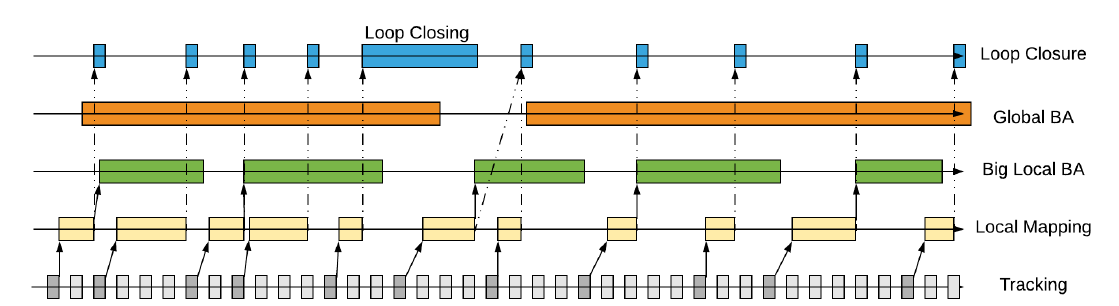
Figure 2. Timing diagram of Global Navigation Satellite System–visual-ORB–simultaneous localization and mapping (GVORB) threads.